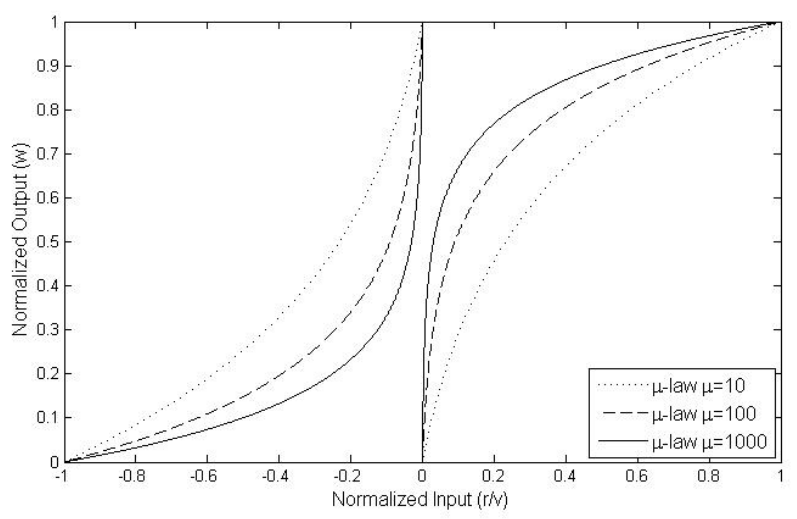
Figure 1. Normalized output versus normalized input under .